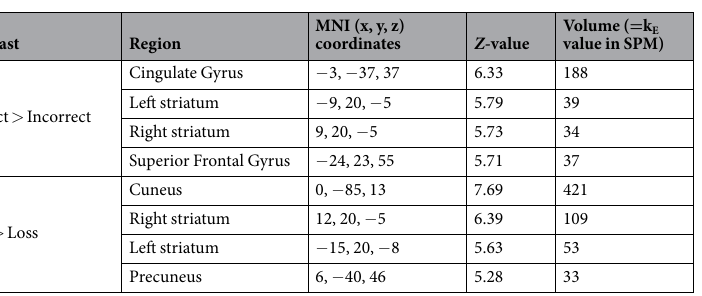
Table 2. All brain coordinates for the whole-brain contrasts Correct > Incorrect, and Gain > Loss in a full factorial design for N = 19 (FWE corrected, p <